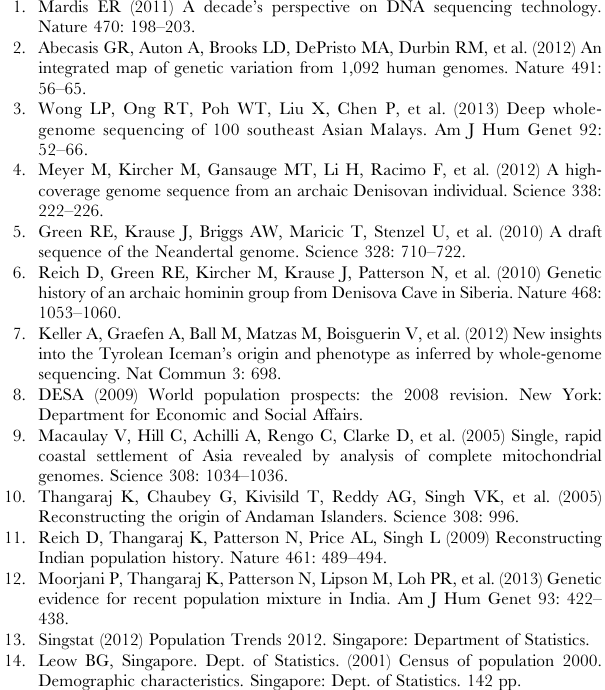
Figure S15 Cross validation error for admixture analysis with K from 2 to 15 performed on 16 populations. Cross-validation error in the admixture analysis at different values of ancestral groups ( K ), which we have allowed to range from 2 to 15. It was observed that while K = 7 yielded the lowest cross-validation error, K = 6 yielded a difference that was less than 0.01 and thus K = 6 was chosen for reporting in the main text on the basis of parsimony. Figure S16 European component in 36 SSIP individuals from admixture analysis. Bars represent average of European compo- nent in 36 SSIP samples from the admixture analysis on 6,519,079 SNPs of 16 populations in which 14 populations from 1 KGP (Table S1), SSMP and SSIP. K indicates the number of ancestral populations. At K = 3, the three ancestral populations are African, European and Asian (Figure 3B) where an average of 53.42% European component was found in 36 SSIP individuals. When K increased, more ancestral populations contributed to the entire admixture panel that likely to dilute the European component possessed by SSIP individuals. Table S1 Description of populations used for comparison with SSIP. Table S2 Description of 25 Indian groups extracted from Reich et al. 2009. Table S3 Transition to transversion ratio (Ts/Tv). (A) Ts/Tv for bi-allelic SNPs, (B) Ts/Tv after the removal of CpG exonic transition SNPs.